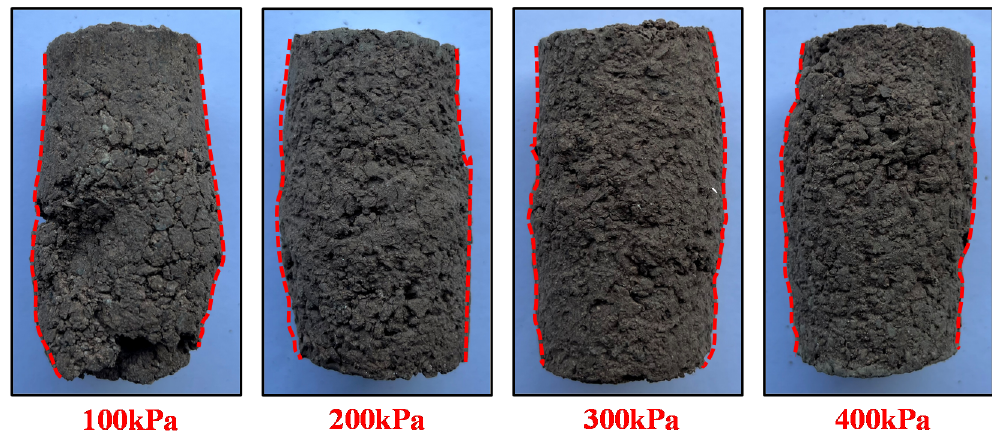
Figure 6. Failure mode of specimens.